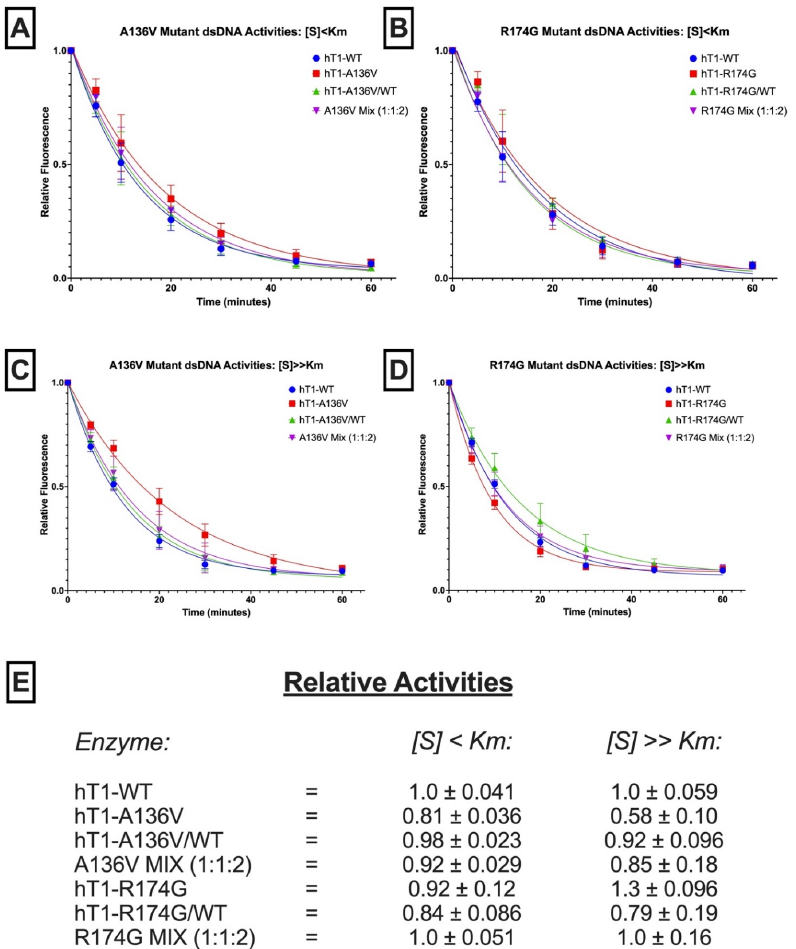
Figure 4. dsDNA exonuclease activities of p.A136V and p.R174G variants. ( A – D ) Fluorescence- Based Quantification of TREX1 dsDNA Degradation . Standard exonuclease reactions were prepared with equimolar concentrations of the indicated enzymes/mixes, incubated at room temperature for the indicated times, quenched in SYBR Green, and dsDNA content measured by fluorescence. Plots of fluorescence vs. time were generated and fit with one ‐ phase decay nonlinear regression in Prism 7.0 (GraphPad). Plots are composites of 18 different reactions from three different experiments. Data points indicate mean, and error bars represent standard deviation. ( E ) Activity Rates of TREX1 Vari ‐ ants . Initial velocities were quantified from the respective regression lines in panels a ‐ d and normal ‐ ized to wild ‐ type initial velocity to calculate relative activity. Values are mean and standard devia ‐ tion. ‘[S] < K m ’ refers to ~1 nM of a 10 ‐ kb dsDNA plasmid, and ‘[S] >> K m ’ refers to ~1 μ M of a 30 ‐ bp self ‐ annealing oligo.